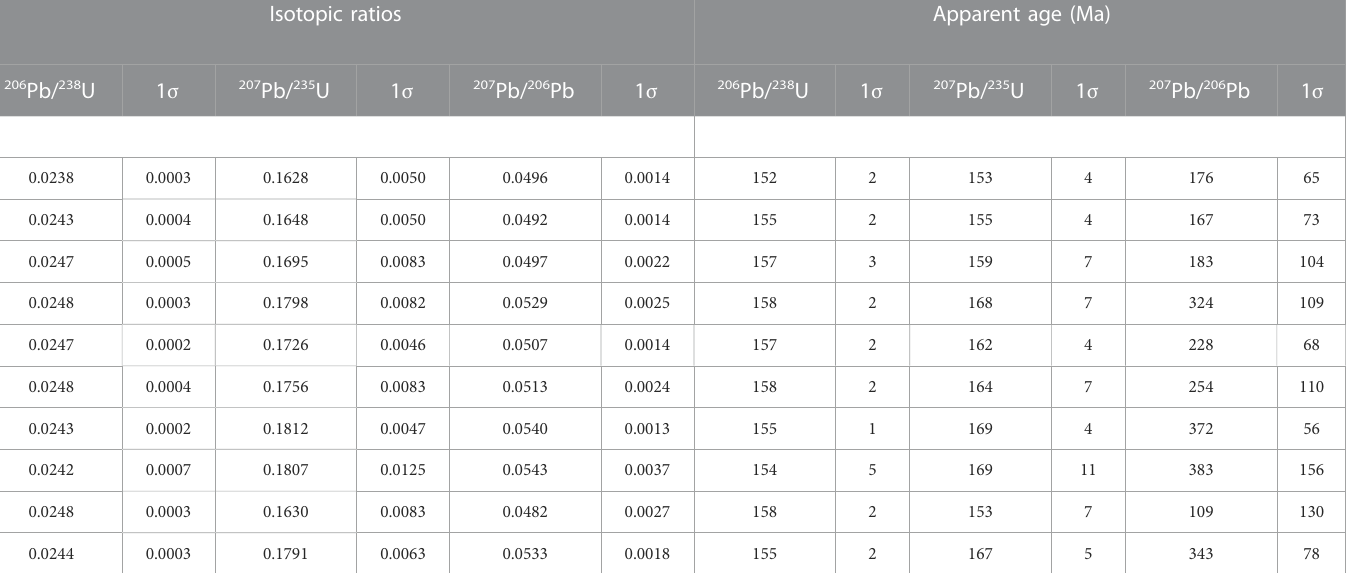
TABLE 2 LA-ICP-MS zircon U-Pb isotopic analysis of the Chuhuertu granite. Spot